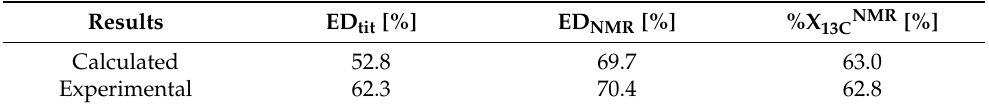
Table 2. Calculated vs. experimental results.